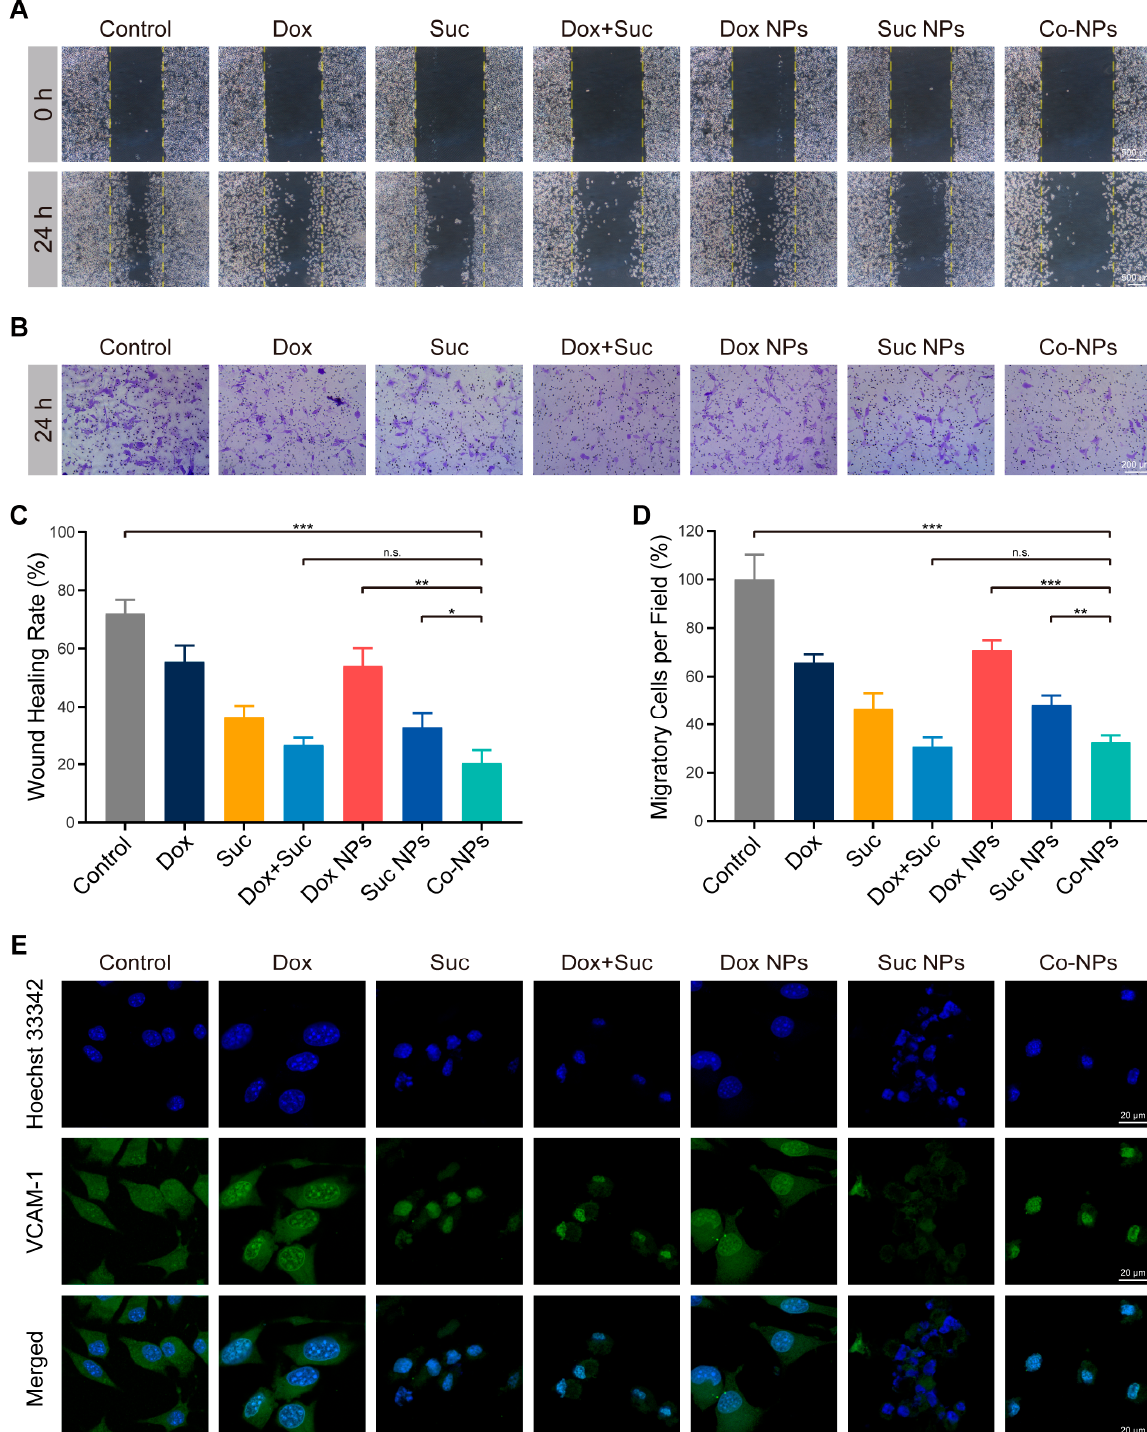
Figure 4. In vitro anti-metastasis effects and inhibitory effects on VCAM-1 expression. ( A ) Typical images of the wound healing assay of different free drugs and nanoparticles. Scale bars = 500 µ m. ( B ) Typical images of the transwell migration assay of different free drugs and nanoparticles. Scale bar = 200 µ m. ( C ) Quantitative analysis of the wound healing assay ( n = 3). ( D ) Quantitative analysis of the transwell migration assay ( n = 3). ( E ) Immunofluorescence assay of VCAM-1 expression on B16F10 cells after treatment with different free drugs and nanoparticles. Scale bars = 20 µ m. (n.s., not significant, * p < 0.05, ** p < 0.01, *** p <